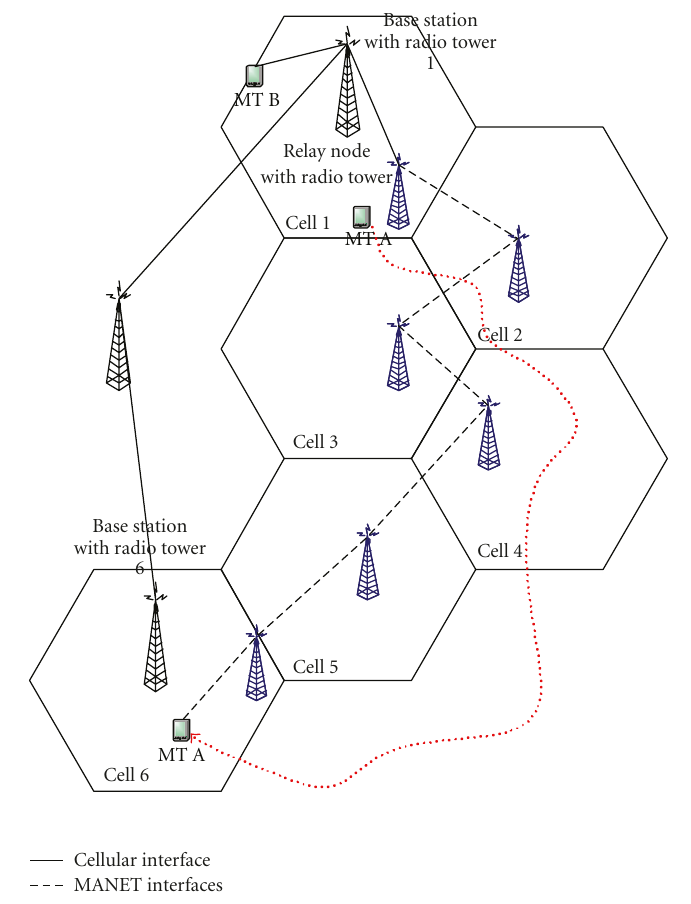
Figure 2: Multihop combined transmission example of cellular resource relaying using fixed